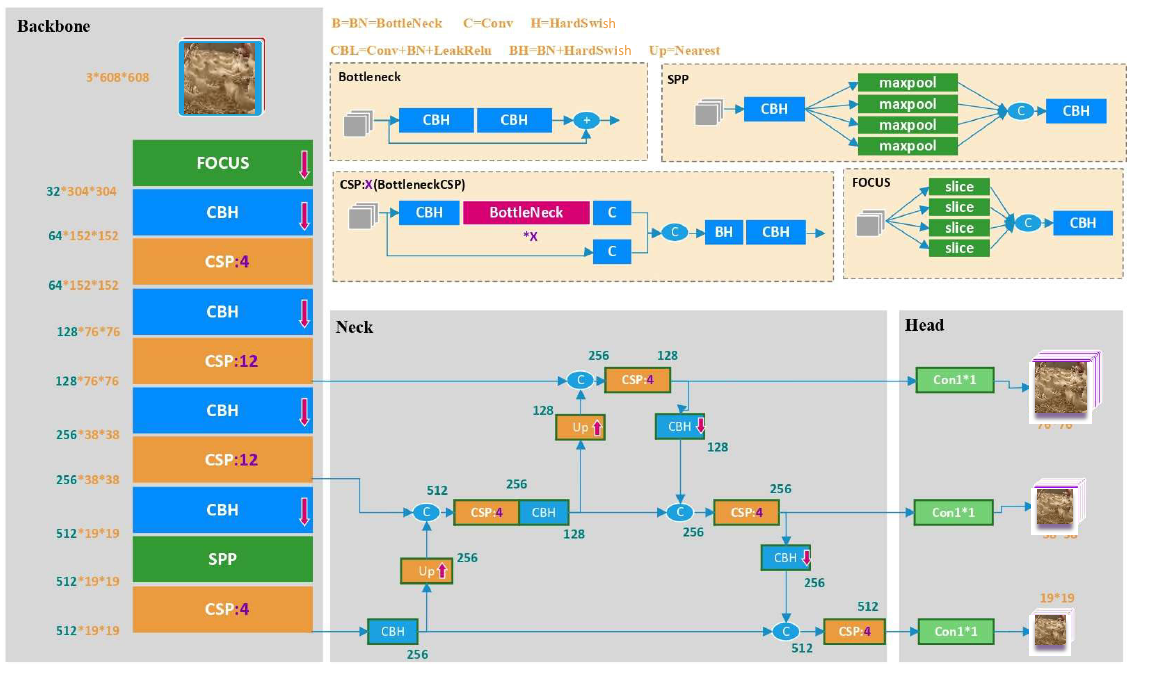
Figure 4. The network structure of YOLOv5x .